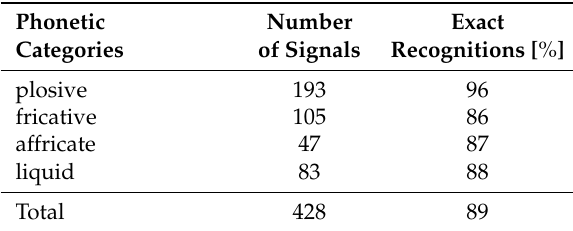
Table 7. Subjective evaluation